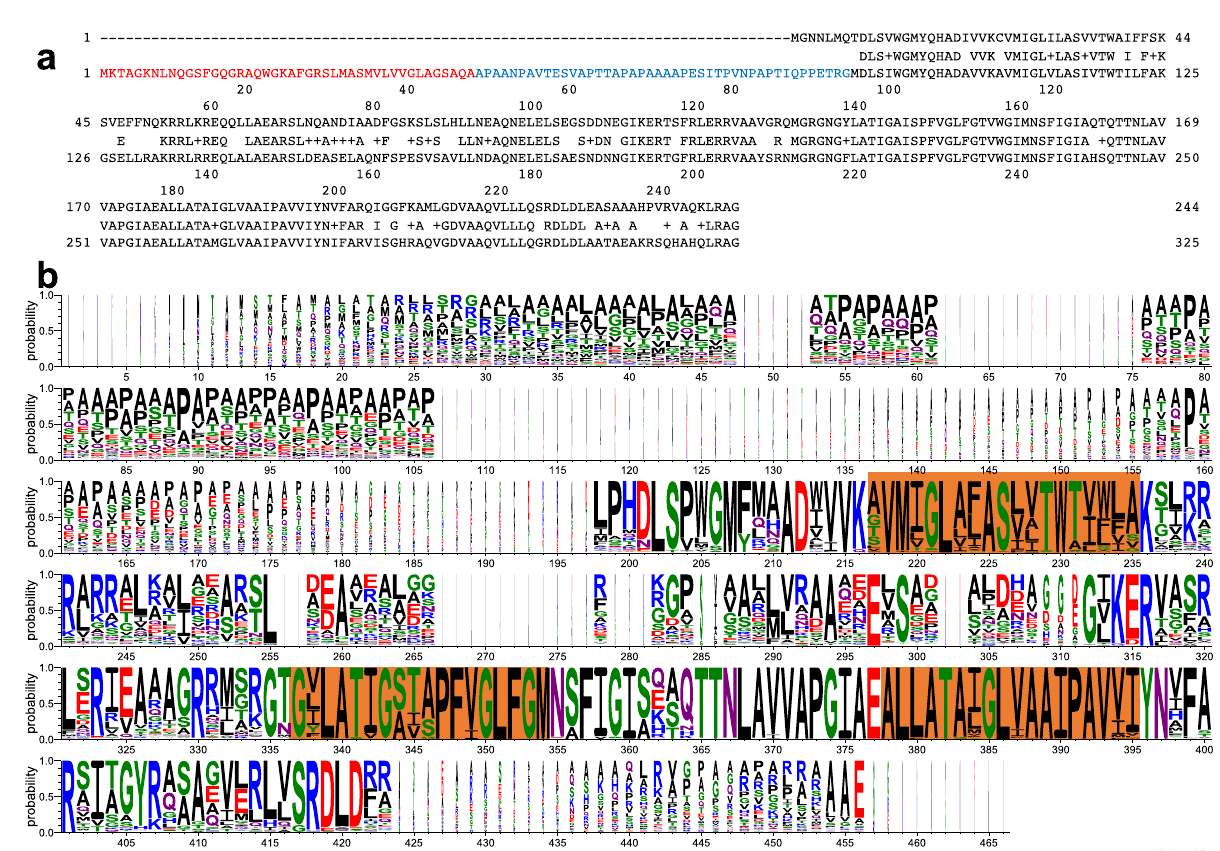
Fig. 1 ExbB sequence analysis. a Alignment of ExbB Ec (top) with ExbB Sm (bottom), made with DNA Strider v1.4x-2b, CEA. In red is shown the signal sequence from ExbB Sm , and in blue the periplasmic extension, not present in ExbB Ec . The consensus sequence is shown on the middle line, where + indicates similar amino acid residues. b Weblogo 59 representation of 131 “ long ” ExbB amino acid sequences aligned with Clustal Omega 60 ; those with much shorter periplasmic extensions have been excluded from the alignment. The orange boxes show the position of the three TM segments from the E. coli 5SV0